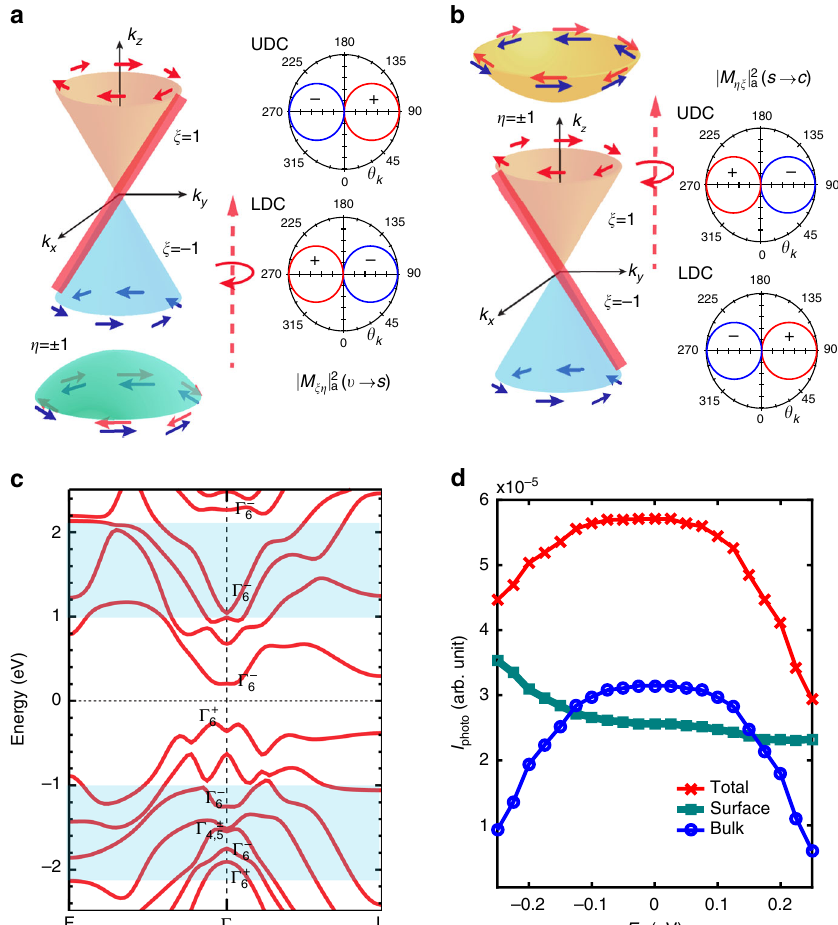
Fig. 4 Theoretical analysis of optical transitions and numerical calculation of photocurrent. a Schematic picture of optical transitions from the bulk valence band to the Dirac surface states. ξ and η denote the spin texture of the surface states and the bulk states, respectively. The asymmetric matrix elements (cid:5) (cid:5) (cid:5)(cid:2) (cid:3) (cid:5) 2 M ξη for the transitions are plotted in the polar graph of momentum angle ( θ k ) for upper and lower Dirac cones (UDC and LDC), where the sign is a denoted by the color ( red denotes positive and blue denotes negative). The asymmetric matrix element is positive on the positive k y side for the UDC, while positive on the negative k y side for the LDC. Therefore, the preferred optical transitions are from the valence band to the right-moving branch of the surface states, denoted by the red coloring on the Dirac cone. b Schematic picture of optical transitions from the Dirac surface states to the conduction band. The asymmetric matrix element is opposite compared to a . Therefore, the preferred optical transitions are from the left-moving branch of the surface states to the conduction band. c First-principle calculation of the bulk band structure of (Bi 0.5 Sb 0.5 ) 2 Te 3 . The irreducible representation to which each bulk band belongs is marked on top of the band. The blue-shaded area identi fi es the energy range, which is ± 1 − ± 2 eV away from the surface Dirac cone, relevant for optical transitions at the photon energy we use. d Calculated photocurrents based on the slab model as a function of the chemical potential. E F = 0 eV denotes the chemical potential located at the Dirac point. The photocurrent contributions from the excited carriers in the surface states ( green curve ), the bulk bands ( blue curve ) and the total photocurrent ( red curve ) are displayed excited electrons ( fi lled blue circles ) and holes ( empty red circles ) in the surface states induce a photocurrent along the same direction. The comparison between (a), (b) and (c) shows that the photocurrent contribution from the surface states changes little with the chemical potential. However, the bulk states contribute to the photocurrent in a very different manner. When the che- mical potential is located at the Dirac point (Fig. 5b), the pho- tocurrent contribution from the bulk bands (identi fi ed by empty blue circles and fi lled red circles ) is maximized along the negative y -direction, denoted by the red and blue arrows . As the chemical potential moves away from the Dirac point, either down toward the valence band or up toward the conduction band as shown in Fig. 5a, c, respectively, the photocurrent contributed from dif- ferent bulk bands partially cancels out and decreases (see inset to Fig. 5). This physical picture accounts for the HDPC reaching a maximum value at the Dirac point.